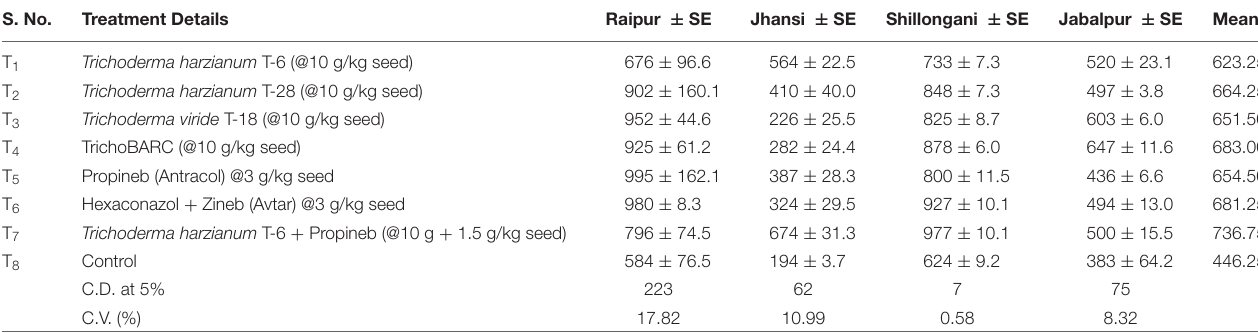
TABLE 2C | Evaluation of new stains of Trichoderma along with fungicides for the management of collar rot of chickpea (2017–2018) – Yield (kg/ha). S. No.